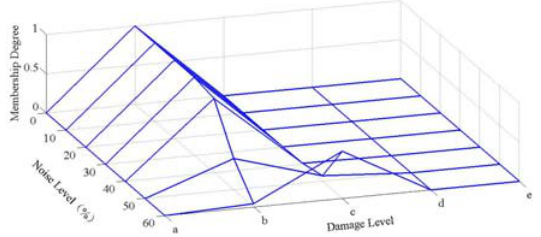
Fig. 11. Anti-noise analysis of element 4 with damage degree